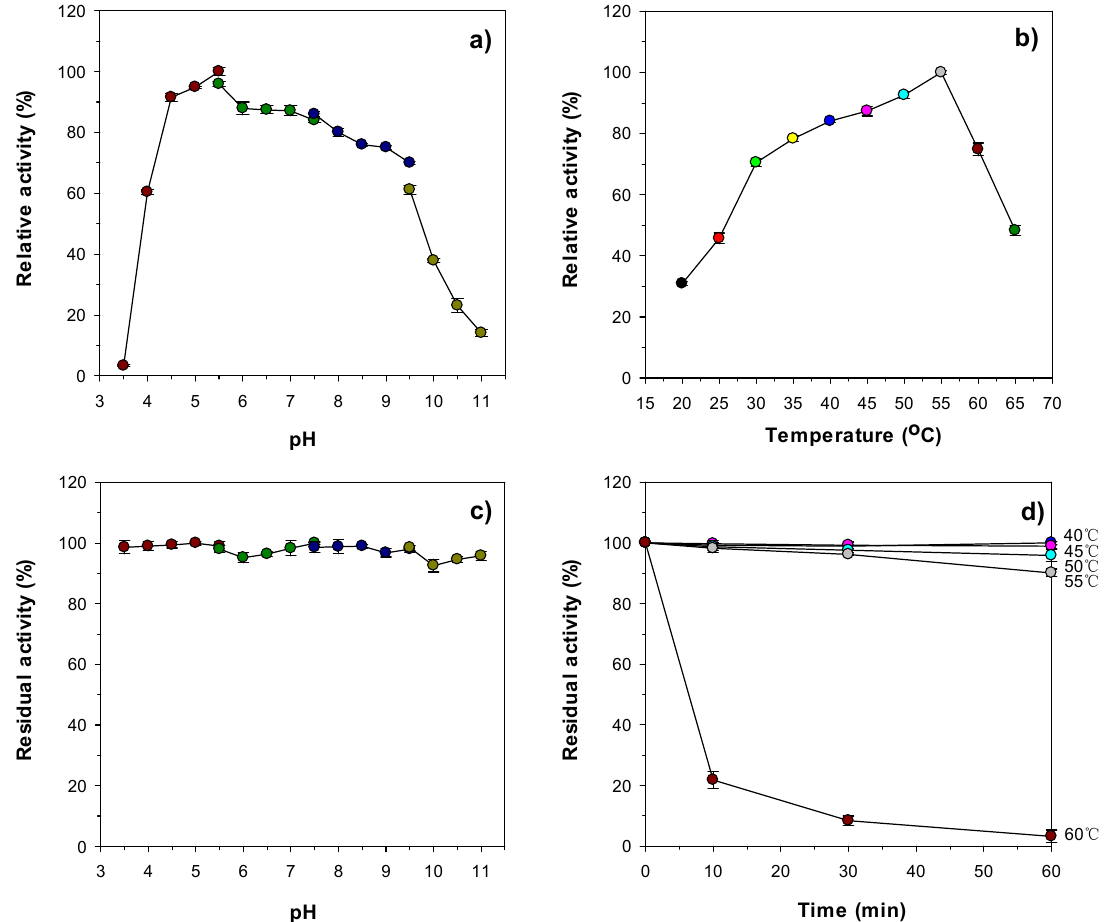
Figure 4. Effects of pH ( a ) and temperature ( b ) on the endochitinase activity of rChiJ and effects of pH ( c ) and temperature ( d ) on the stability of rChiJ. The optimal pH of rChiJ was determined using the following buffers (50 mM): sodium acetate (pH 3.5–5.5), sodium phosphate (pH 5.5–7.5), Tris-HCl (pH 7.5–9.5), and glycine-NaOH (pH 9.5–11.0). The optimal temperature of rChiJ was evaluated at different temperatures (20–65 °C) in 50 mM sodium acetate buffer (pH 5.5). The pH stability of rChiJ was examined at pH 3.5–11.0 after preincubation of the enzyme using the aforementioned buffer systems at 4 °C for 60 min. The thermal stability of rChiJ was assessed by measuring its residual endochitinase activity after preincubation of the enzyme at 40, 45, 50, 55, and 60 °C in 50 mM sodium acetate buffer (pH 5.5) for 10, 30, and 60 min, respectively. The values are mean ± SD of triplicate tests.